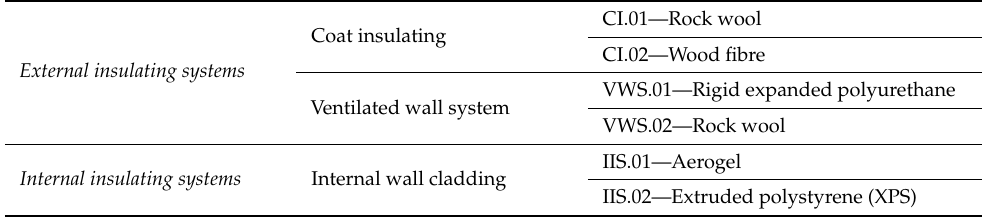
Table 1. Abacus of the thermal insulating